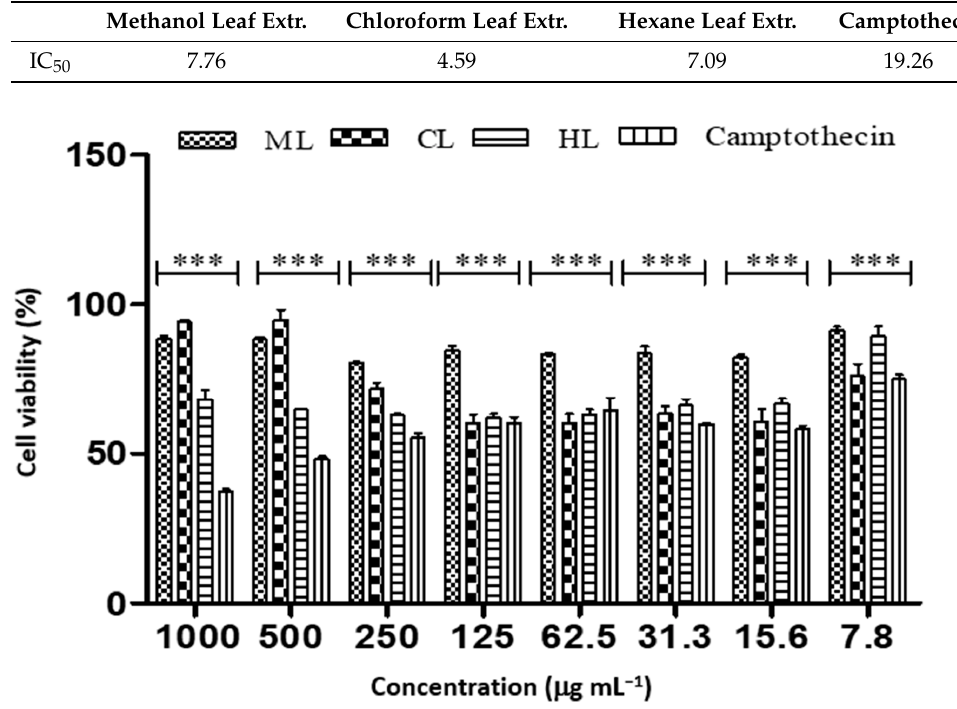
Figure 7. Cell viability of A549 cancer cell lines treated with different concentrations of D. villosa leaves extract. *** (ML vs. Camptothecin), p < 0.001. In addition, the cell viability of A549 cells was observed to be lower on exposure to hexane stem extract (with IC 50 value of 5.35 µg mL − 1 ), chloroform stem extract (IC 50 of 10.67